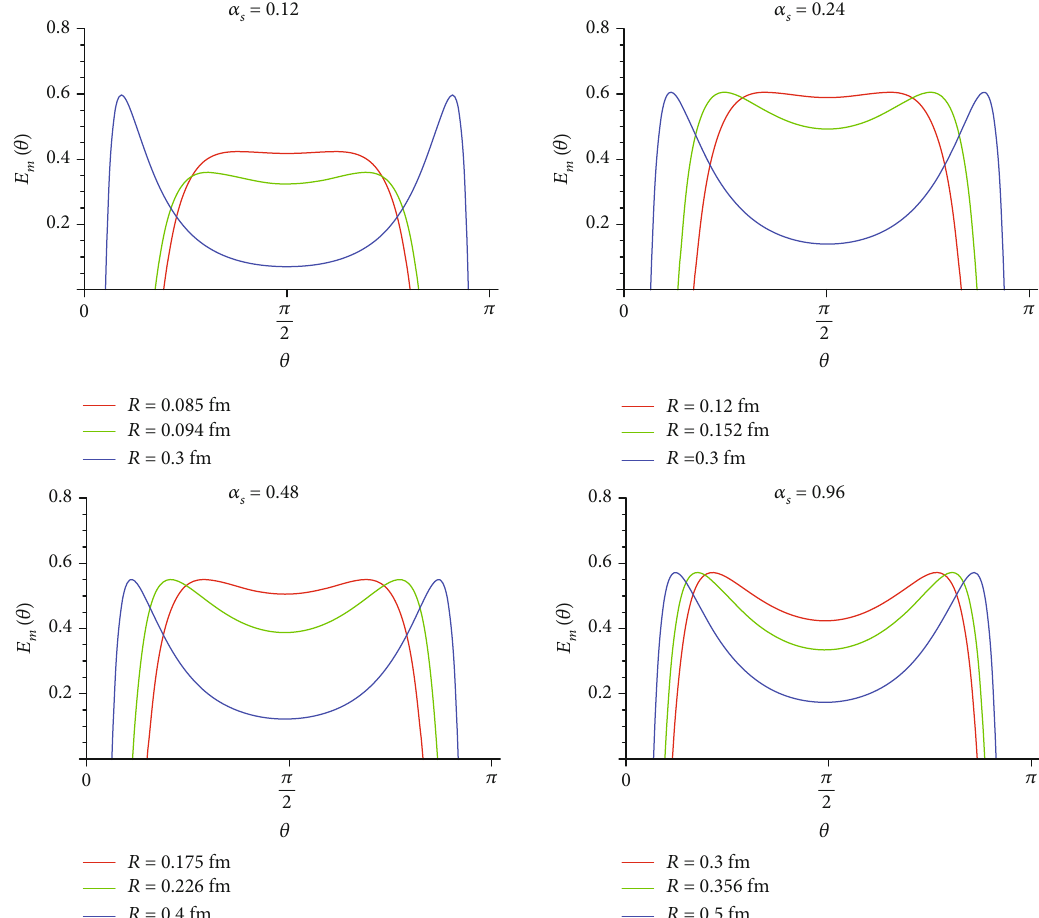
Figure 2: (color online) Pro fi les of color electric fi eld E